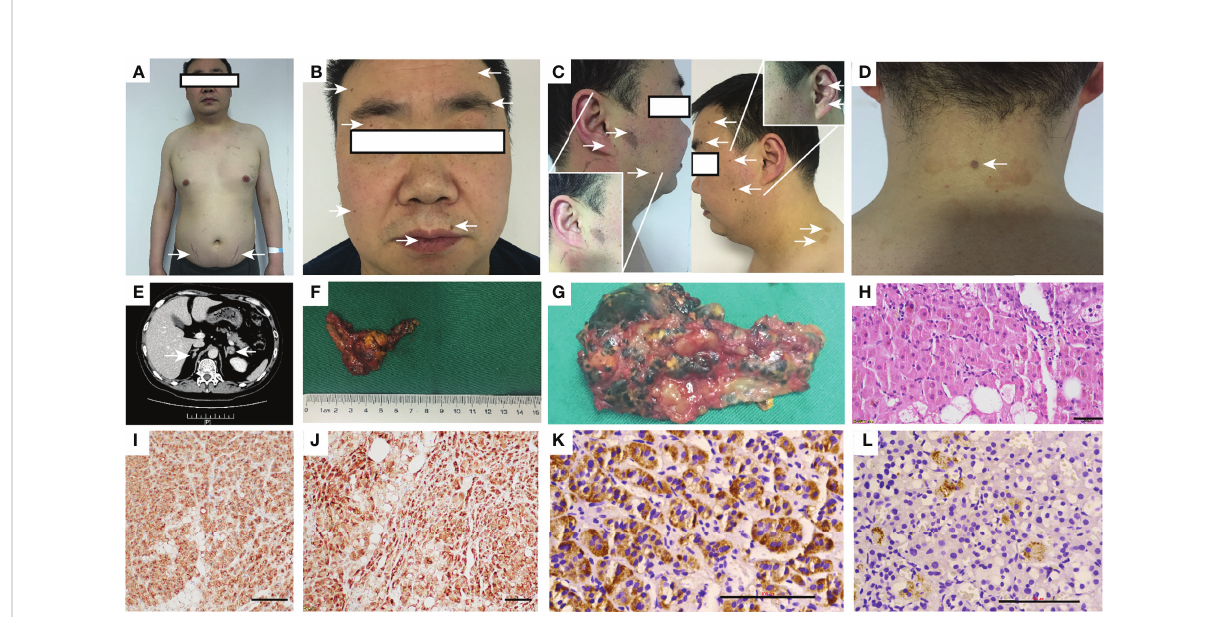
FIGURE 1 Appearance of the patient, adrenal CT, postoperative gross, HE and histochemical staining. (A) Appearance and lower abdomen purple streaks; (B, C) Lip mucosa and multiple skin spot-like pigmentation; (D) Posterior neck skin myxoma; (E) Adrenal CT: bilateral adrenal nodules, the left side diameter is 1.9 cm, the enhanced CT value is approximately 40 HU; (F, G) Postoperative gross after left adrenalectomy: The diseased tissue is grayish-yellow – gray – brown, 4.5 (cid:129) 2.5 (cid:129) 2 cm, multinodular, some cells have pigmentation, and the surrounding cortex is squeezed and thinned; (H) After hematoxylin-eosin staining, brown are seen particles (cid:129) 400; (I – L) Immunohistochemistry of SYN ( (cid:129) 200), Inhibin- a ( (cid:129) 200), CYP11B1and CYP11B2 ( (cid:129) 400). CT, Computed tomography; HE,